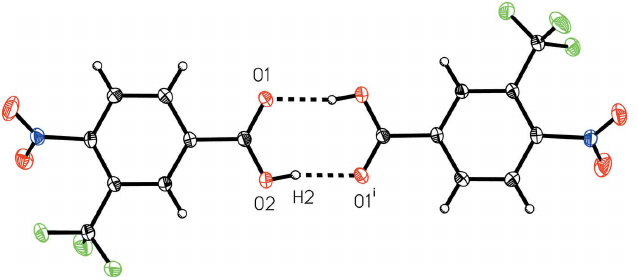
Figure 5 A view of the intermolecular hydrogen bonding in 4-nitro-3-(trifluoro- methyl)benzoic acid (II). [Symmetry code: (i) (cid:5) x , (cid:5) y + 1, (cid:5) z .]